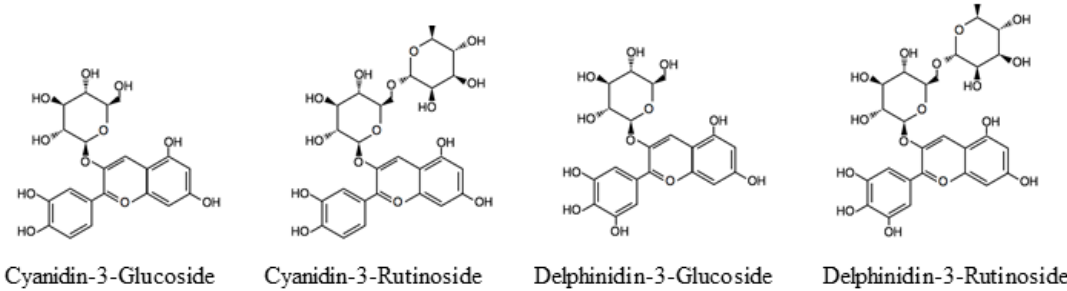
Figure 1. Chemical structures of anthocyanins derived from blackcurrant.